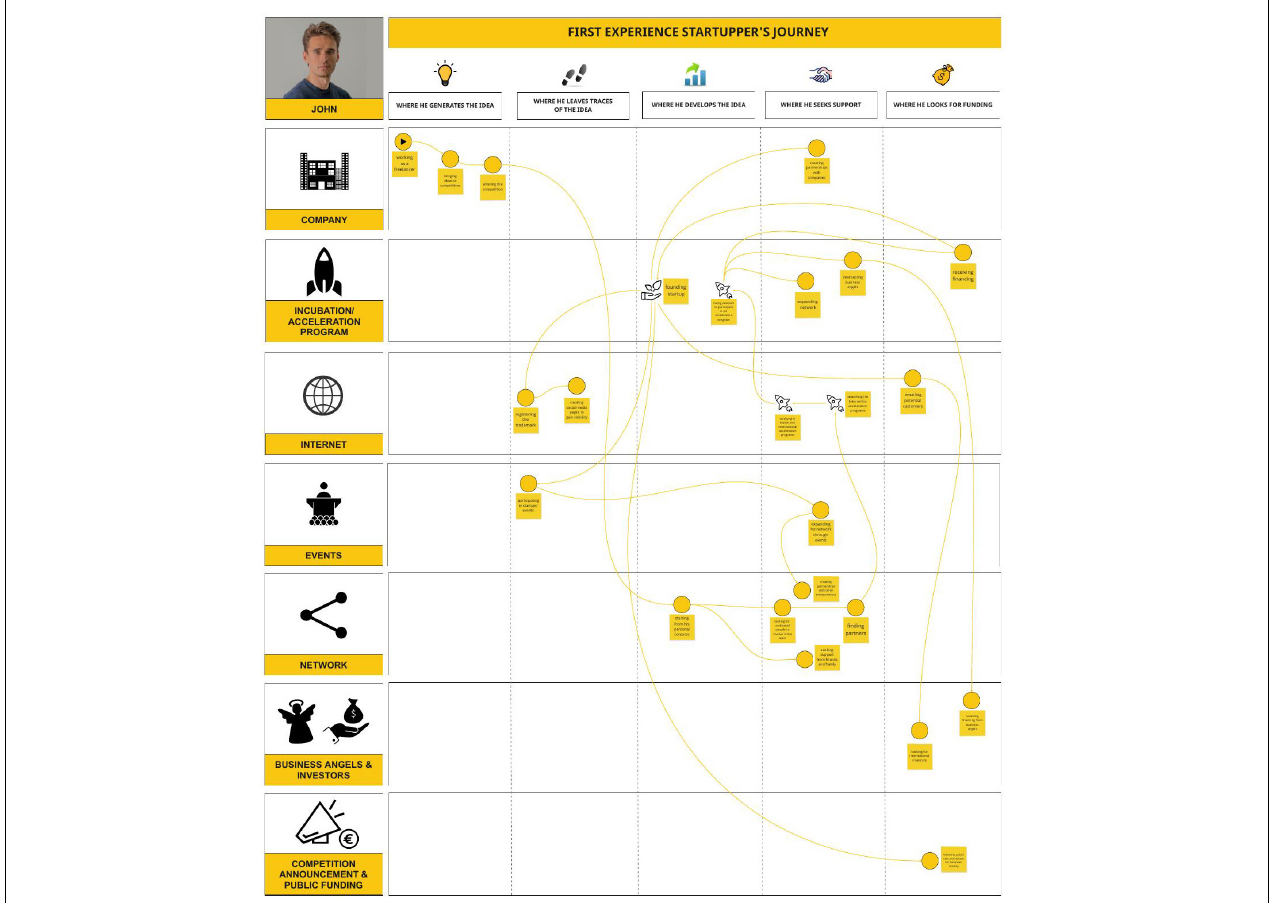
FIGURE 1 | User journey